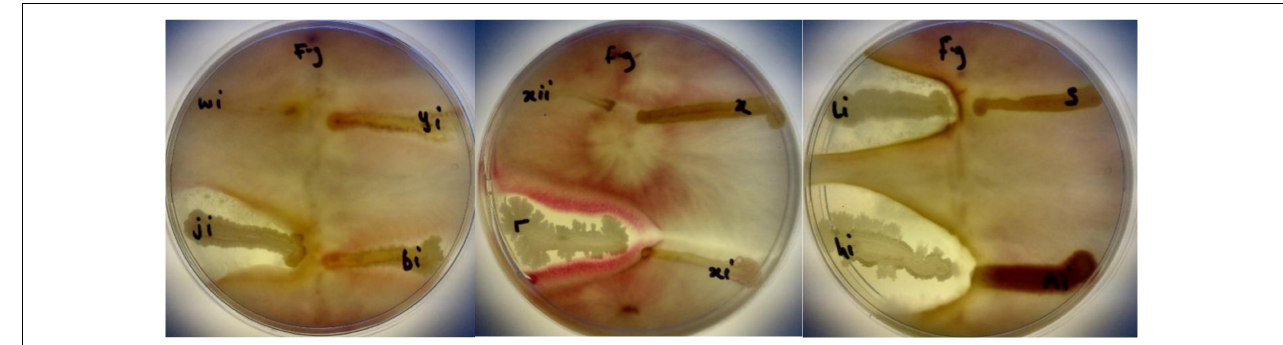
FIGURE 9 | Antifungal activities of BAMji, BAMr, BAMli, and BAMhi against F. graminearum ( Source: Ajilogba and Babalola, 2019).